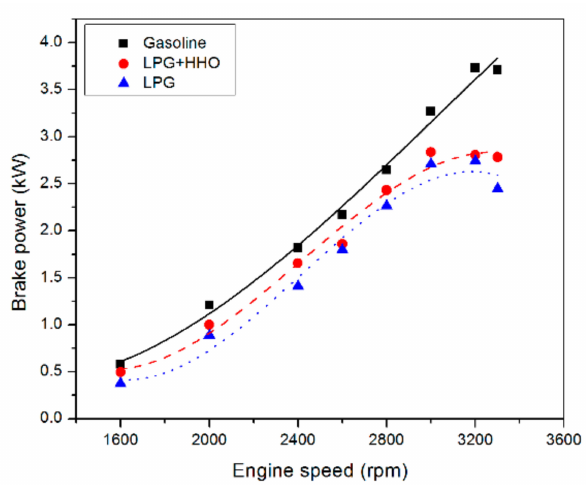
Figure 2. Comparisons of brake power at various engine speed for gasoline, LPG and LPG-HHO blend.